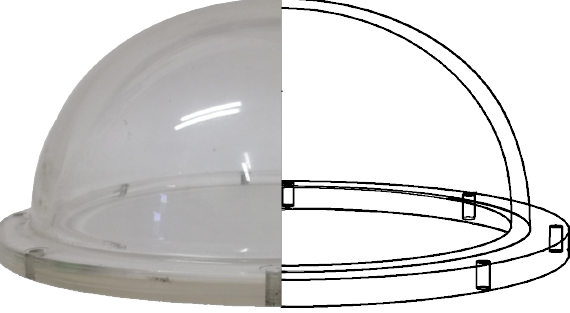
Figure 20. Dome designed for